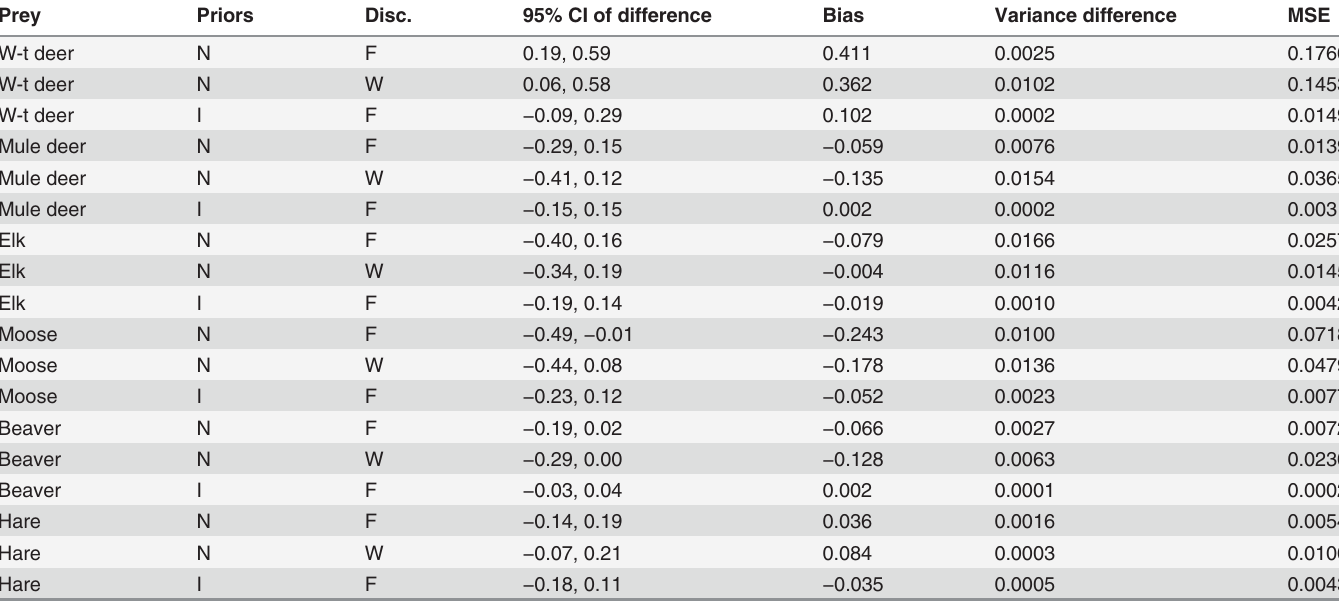
Models were estimated with combinations of non-informative priors (N), informative priors (I), fox discrimination factors (F), and wolf discrimination factors (W). The three models represented in the table were compared to a fourth model (assumed to be closest to the true diet) speci fi ed with informative priors and gray wolf discrimination factors. Variance difference was calculated as the variance of each model subtracted by the variance of the fourth